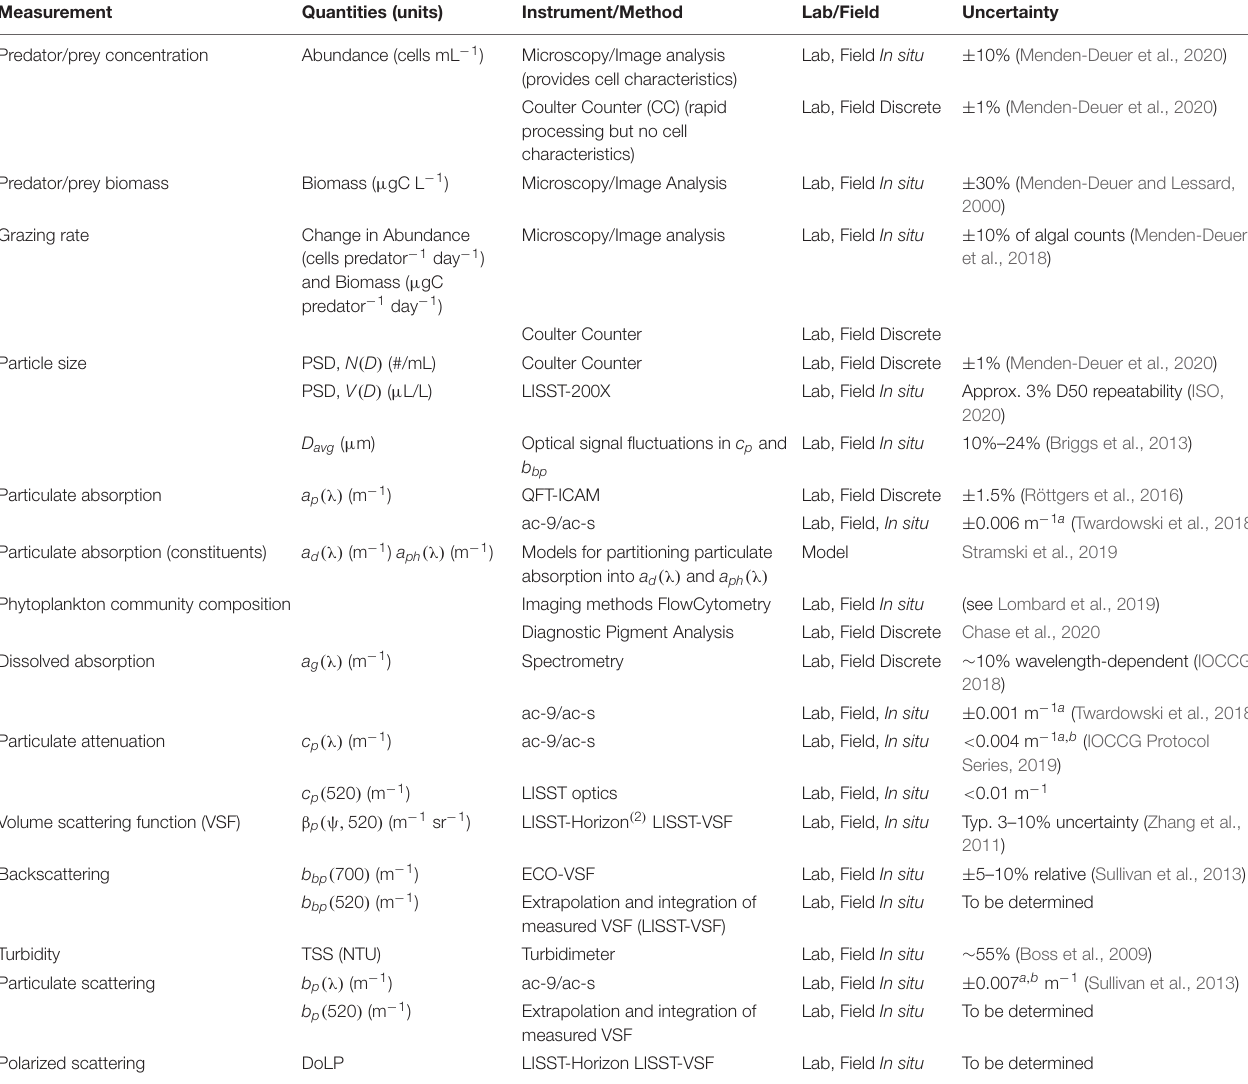
TABLE 1 | Examples of measurement approaches that can aid in quantifying grazing impacts on the optical properties of seawater, their methodologies, applicability to lab and/or field studies, and estimated